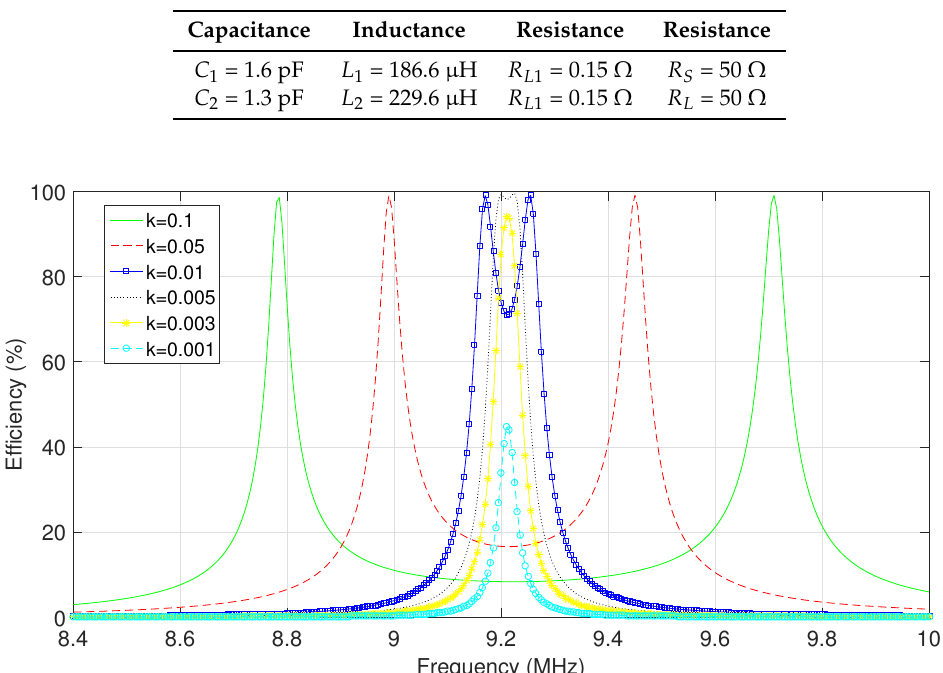
Figure 4. Calculated efficiency of the system with high Q of the transmitter and receiver coils, built based on the value of the elements from Table 1.